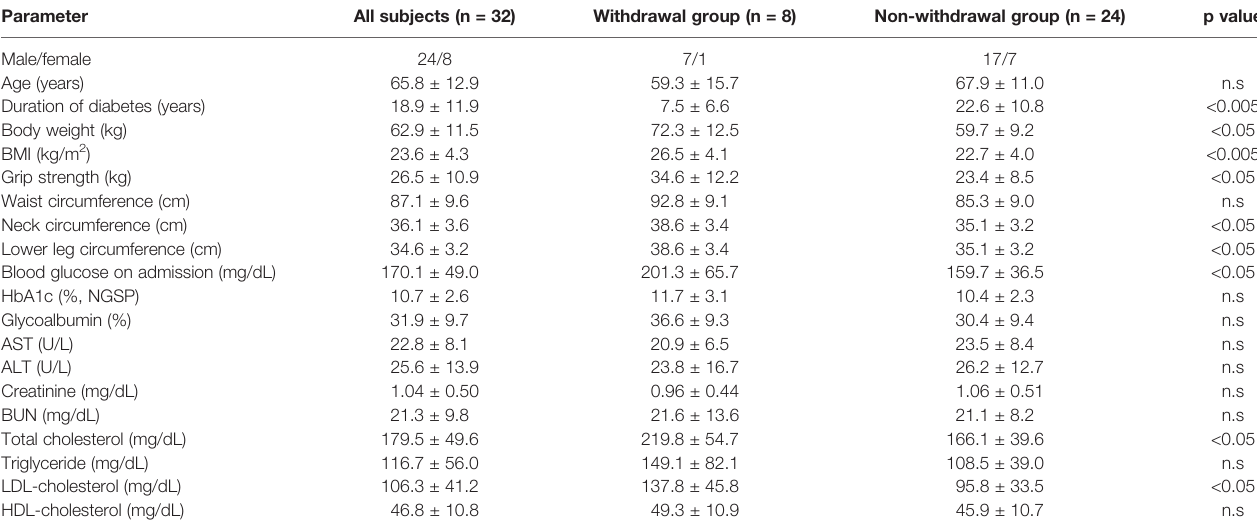
TABLE 6 | Clinical characteristics of patients with D CPR of less than 1.0